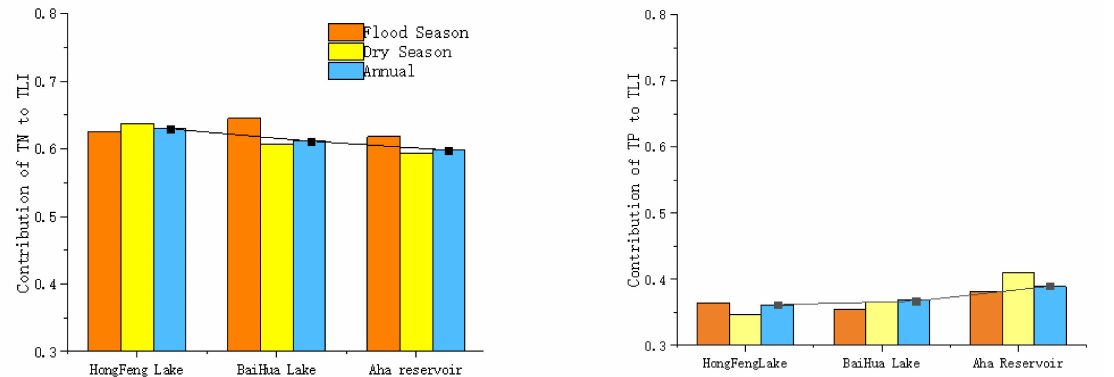
Figure 8. Contribution rate of TN ( left ) and TP ( right ) to TLI in the reservoirs.